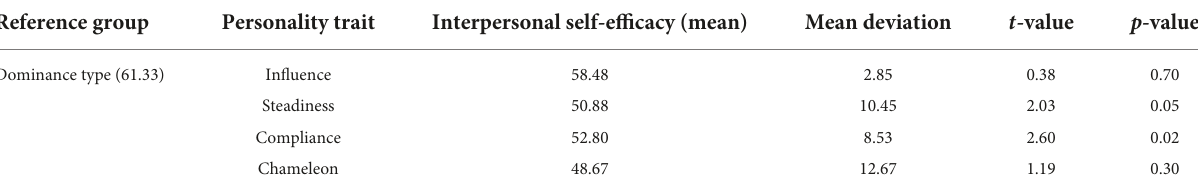
TABLE 6 Mean difference results comparing interpersonal self-efficacy scores of different personality traits. Reference group Personality trait Dominance type